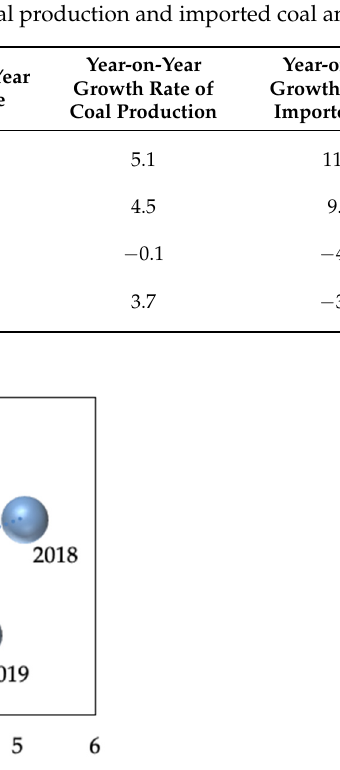
Table 2. The growth rate of power generation, GDP, coal production and imported coal amount.